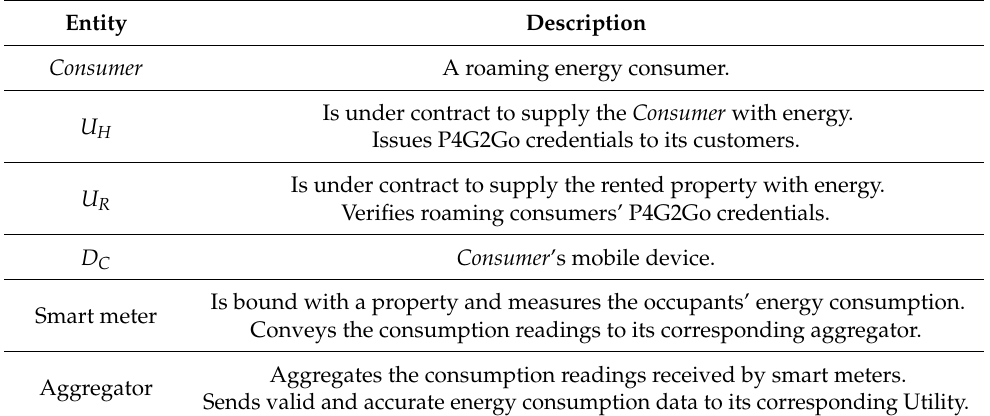
Table 1. Main entities participating in